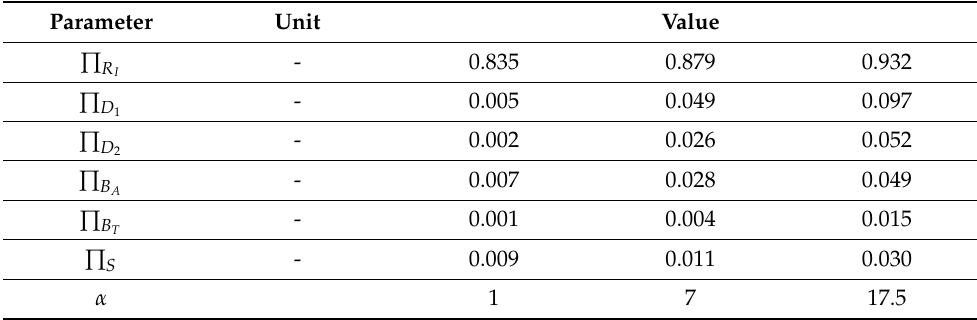
Table 2. Range of geometry parameters in the screening